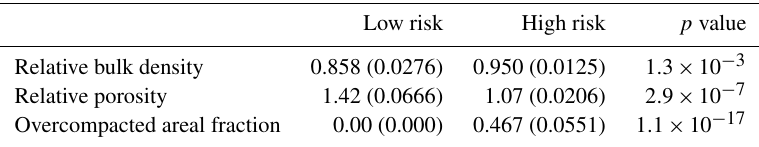
Figure 3. Estimated means of subsoil compaction parameters and areal fractions of overcompacted subsoils for the five risk map units. The error bars indicate the standard error of the estimated means or areal fraction Table 1. Design-based estimates of means of two subsoil compaction parameters and of overcompacted areal fraction for the low-risk groups (map units 1 and 2) and high-risk groups (map units 3, 4 and 5). In brackets: standard